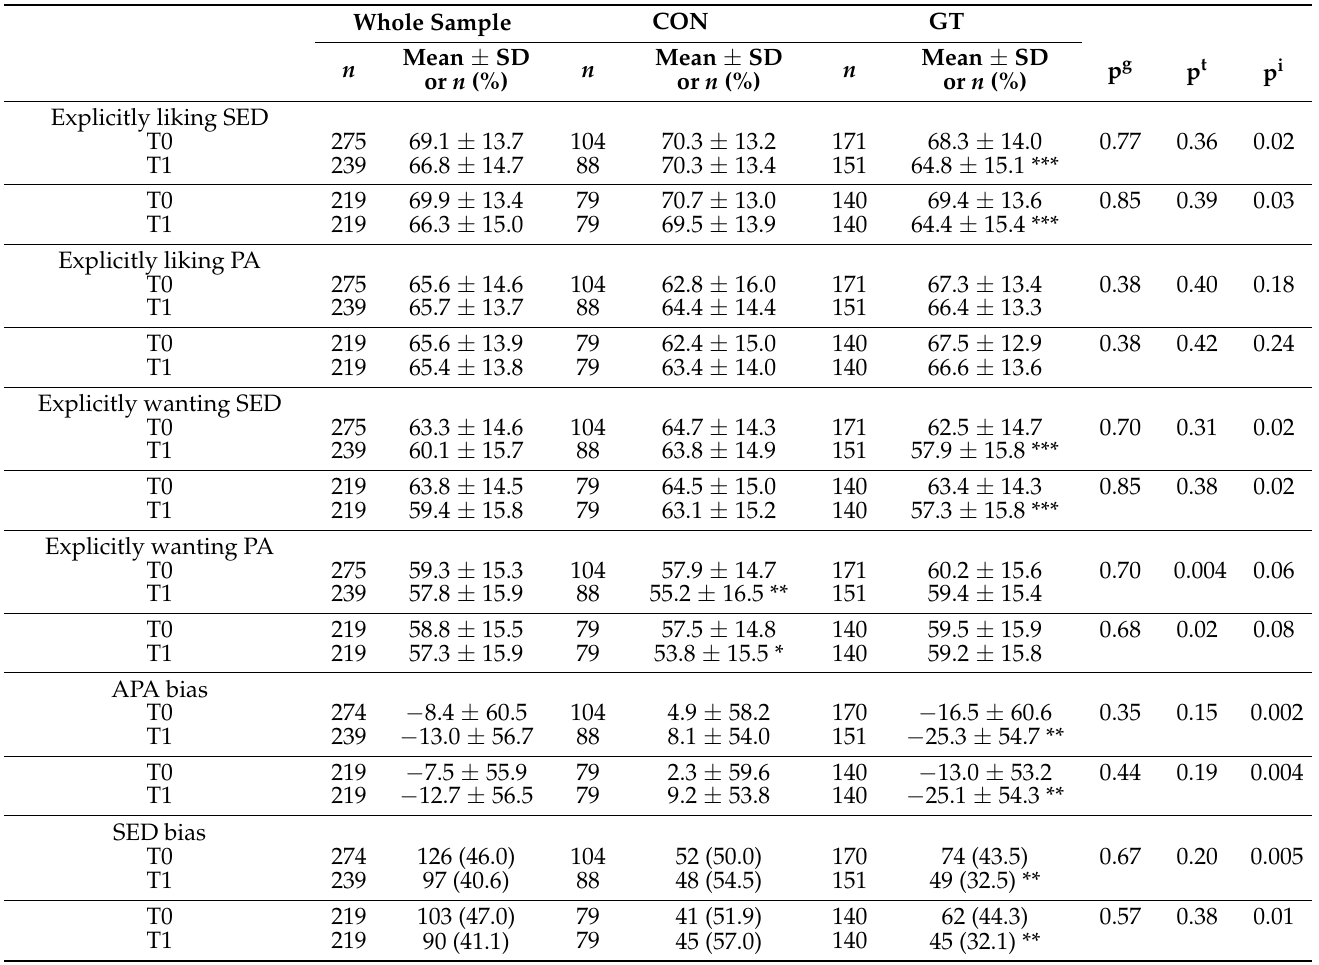
Table 2. Results from the cognitive activity preference assessment (APA) at baseline (T0) and one month later (T1) according to control (CON) and Globe Trotter (GT) groups. Whole